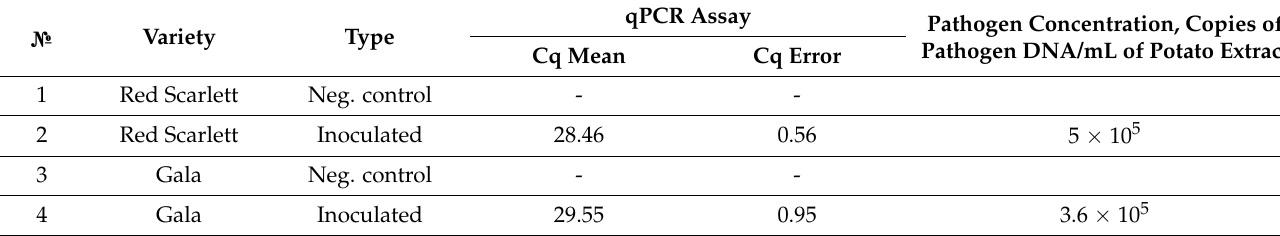
Table 3. Model experiment of Pat detection in potato